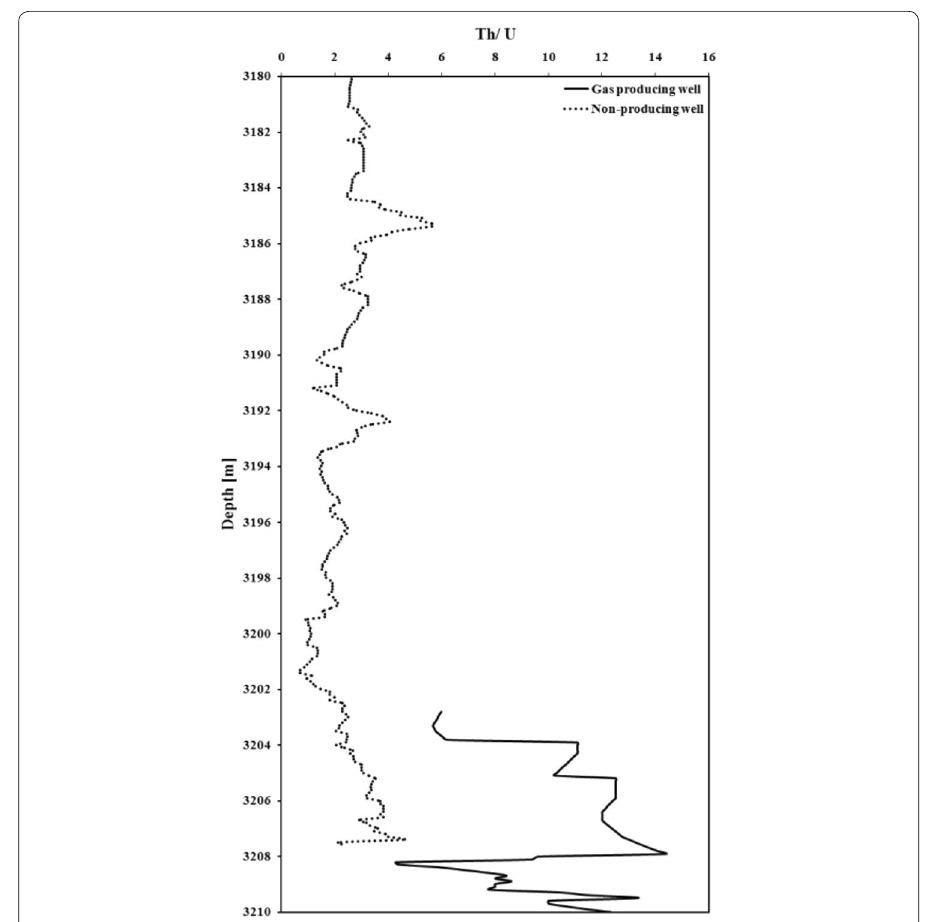
Fig. 10 Th/U ratio in the Shurijeh reservoir